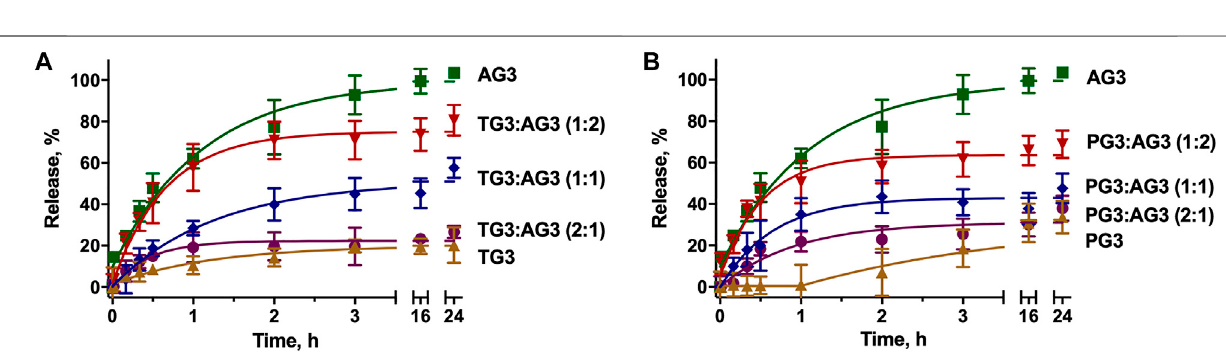
FIGURE 3 | Kinetic pro fi les of dendriplexes release from the agarose gel. Dendriplexes contain either AG3 and TG3 (A) or AG3 and PG3 (B) in different ratios. Charge ratio 5.